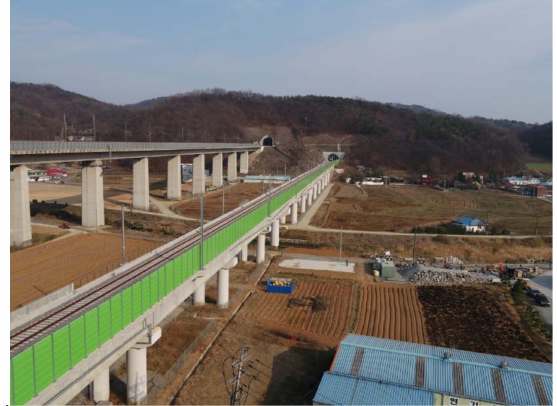
Figure 20. Osong test track fifth bridge in Korea.